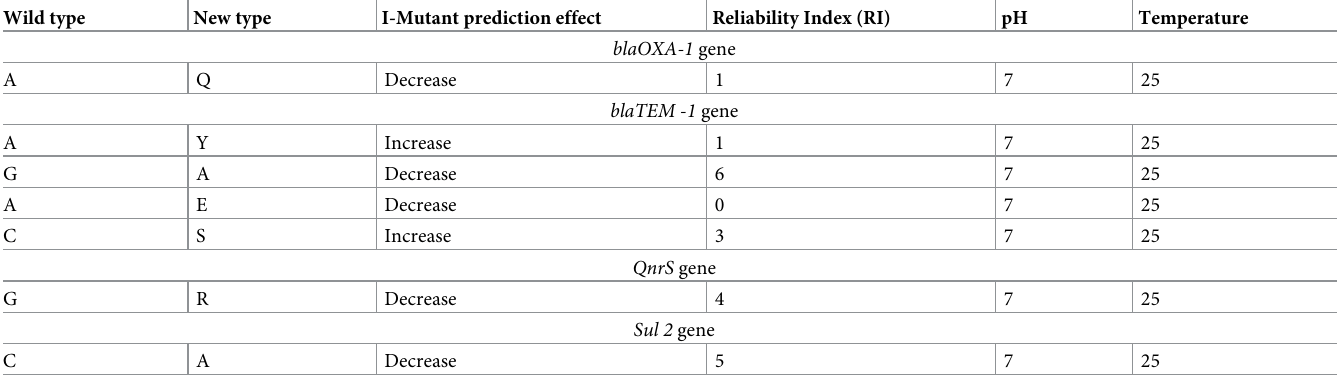
Table 8. I-Mutant software prediction